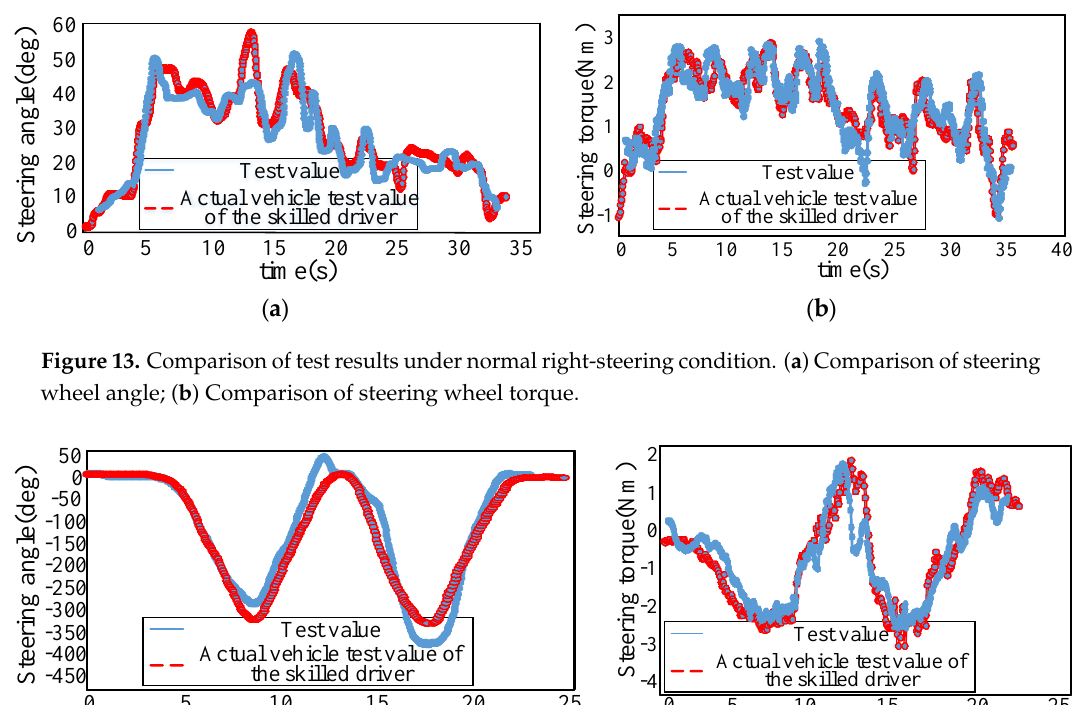
Figure 12. Human-simulated Steering System Rapid Control Prototype Test Bench.